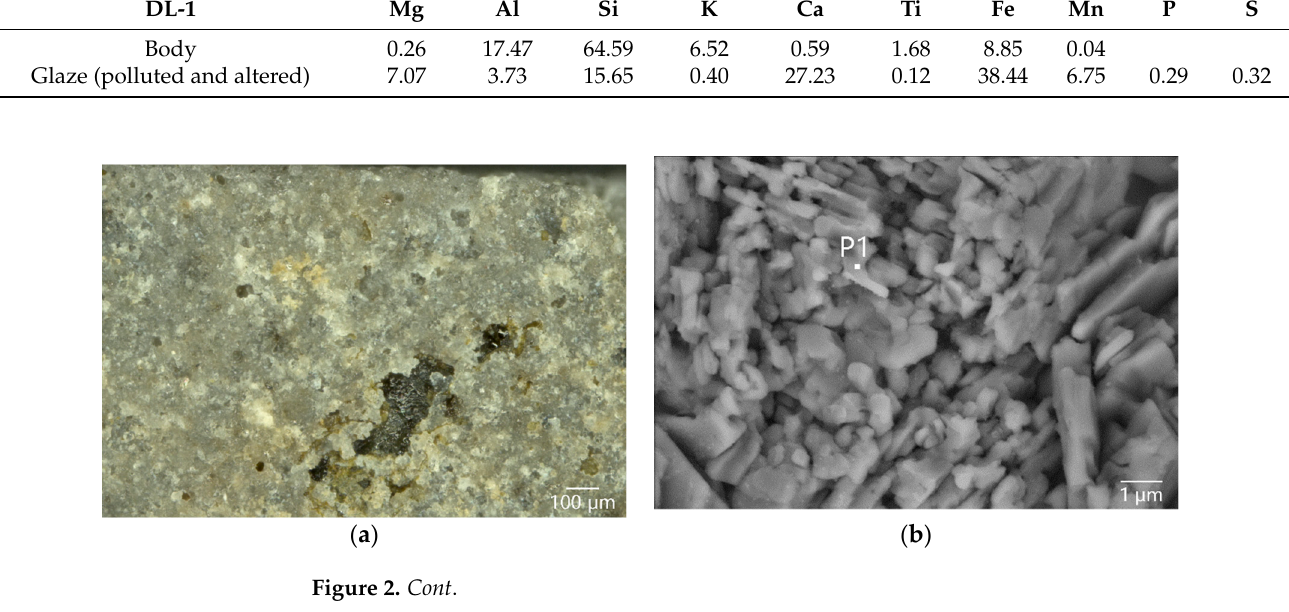
( c ) Figure 2. Morphology of the outer surface of sample DL-1: ( a ) OM image, showing the naked body at the local spalling position of the glaze; ( b ) SEM image, showing the rod-like anorthite crystals in the body/glaze interlayer exposed from the breakage of the glaze; and ( c ) SEM image, showing the sill-like crystal clusters composed of mullite crystals. Figure 3. OM image of the cross-section of sample DL-2, showing a lot of quartz particles in the body. Figure 4a showed a magnified OM image of a cross-section of DL-2 at a position with residual yellow-green glaze on the outer surface. Based on the SEM image, most of the glaze was spalled, and only part of the anorthite interlayer remained, as shown in Figure 4b. The EDS data indicated that the content of Mg of the residual interlayer was as high as 13.54 wt% (P3 of Table 2), which could be attributed to the deposition of Mg 2+ from the seawater at the aforementioned position. As shown in Figure 4b, two circular pores, with a diameter of approximately 30 μ m and 20 μ m, respectively, could be observed in the residual interlayer. The holes were surrounded by anorthite crystals. A layer of foreign